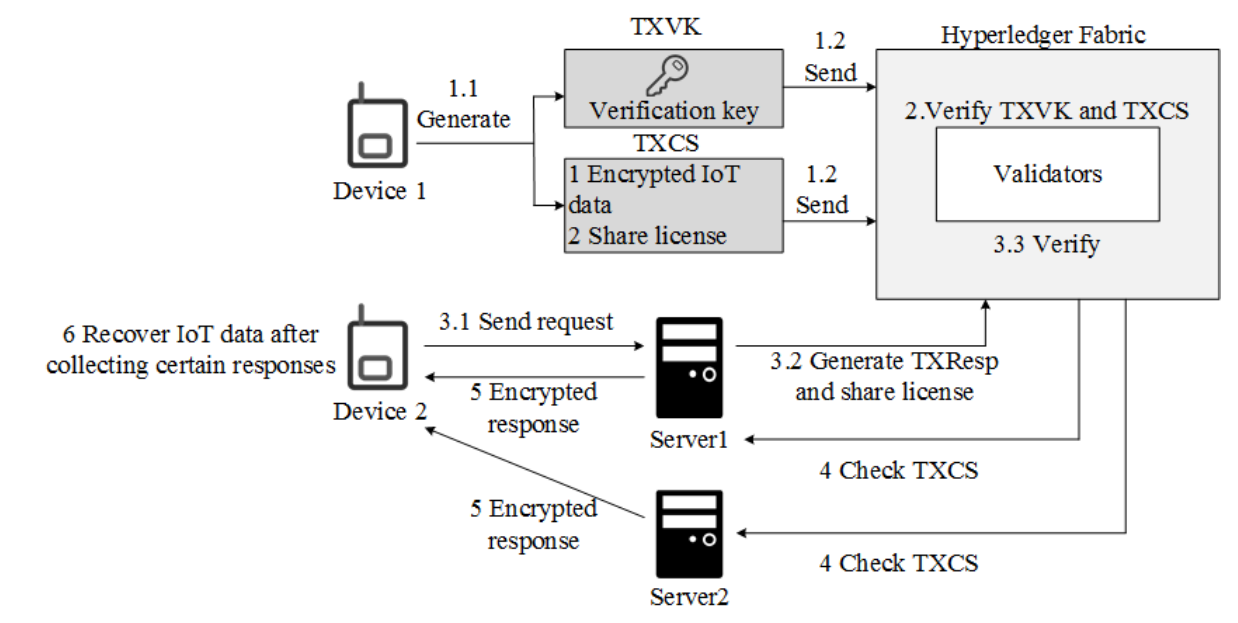
Figure 17. Reconstruction diagram of reference [40].